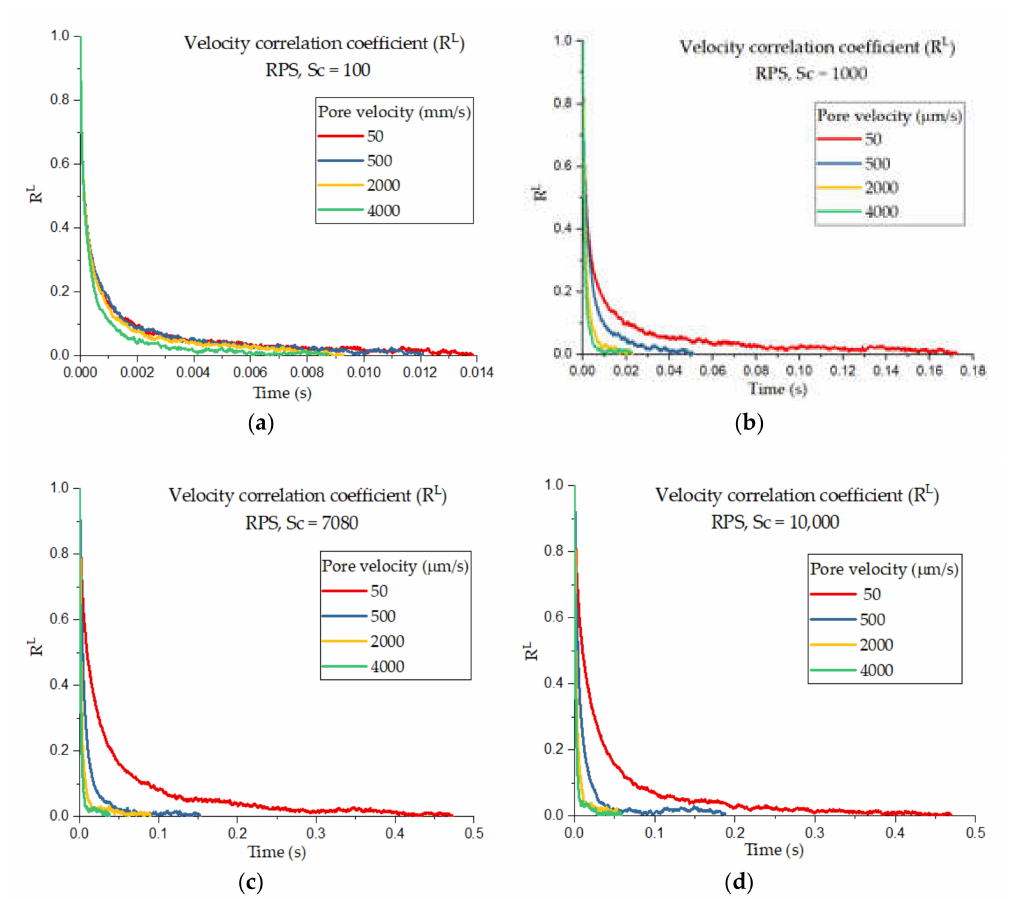
Figure 4. The velocity correlation coe ffi cients for the packed bed with an RPS geometry with time for ( a ) Sc = 100, ( b ) Sc = 1000, ( c ) Sc = 7080, and ( d ) Sc = 10,000. Each graph contains velocity autocorrelation coe ffi cients for di ff erent average pore velocities.